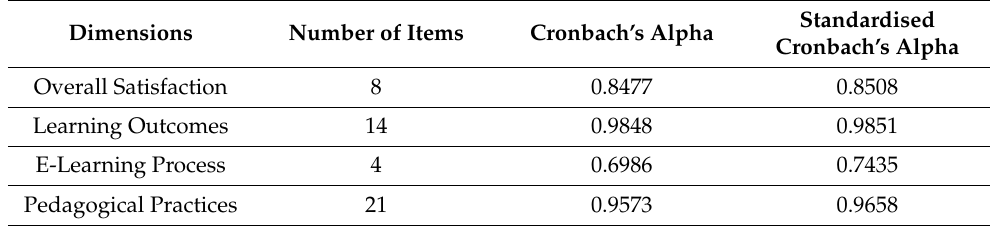
Table 1. Reliability by Cronbach’s alpha for the major